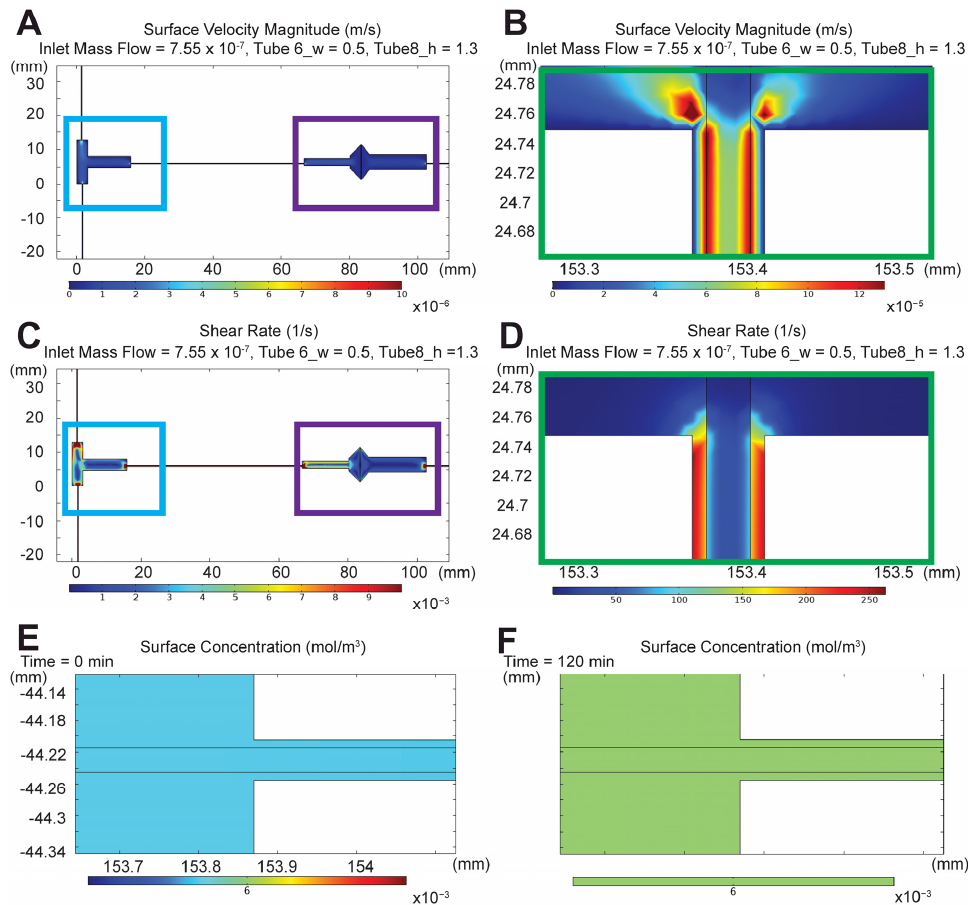
Figure 3. 2D COMSOL ® velocity magnitude, shear rates, and concentration profiles. ( A ) Velocity magnitude (m/s) in T-junction and glomerular housing unit. ( B ) Velocity magnitude (m/s) in proximal convoluted tubule (PCT) device. ( C ) Shear tate (S − 1 ) in T-junction and glomerular housing unit. ( D ) Shear rate (S − 1 ) in PCT device. ( E ) Protein concentration (mg/mL) at time 0 min. ( F ) Protein concentration (mg/mL) at time 120 min. X and Y axes = XY geometry coordinates (mm). Blue = T-junction. Purple = glomerulus housing unit. Green = PCT device. Color bar ranges from lowest (blue) to highest measurements (red), where ( A ) 0–10 × 10 − 5 m/s, ( B ) 0–12 × 10 − 5 m/s, ( C ) 0–12 × 10 − 3 S − 1 , ( D ) 0–250 S − 1 , ( E ) 0–6 × 10 − 3 mol/m 3 , and ( F ) 0–6 × 10 − 3 mol/m 3 .